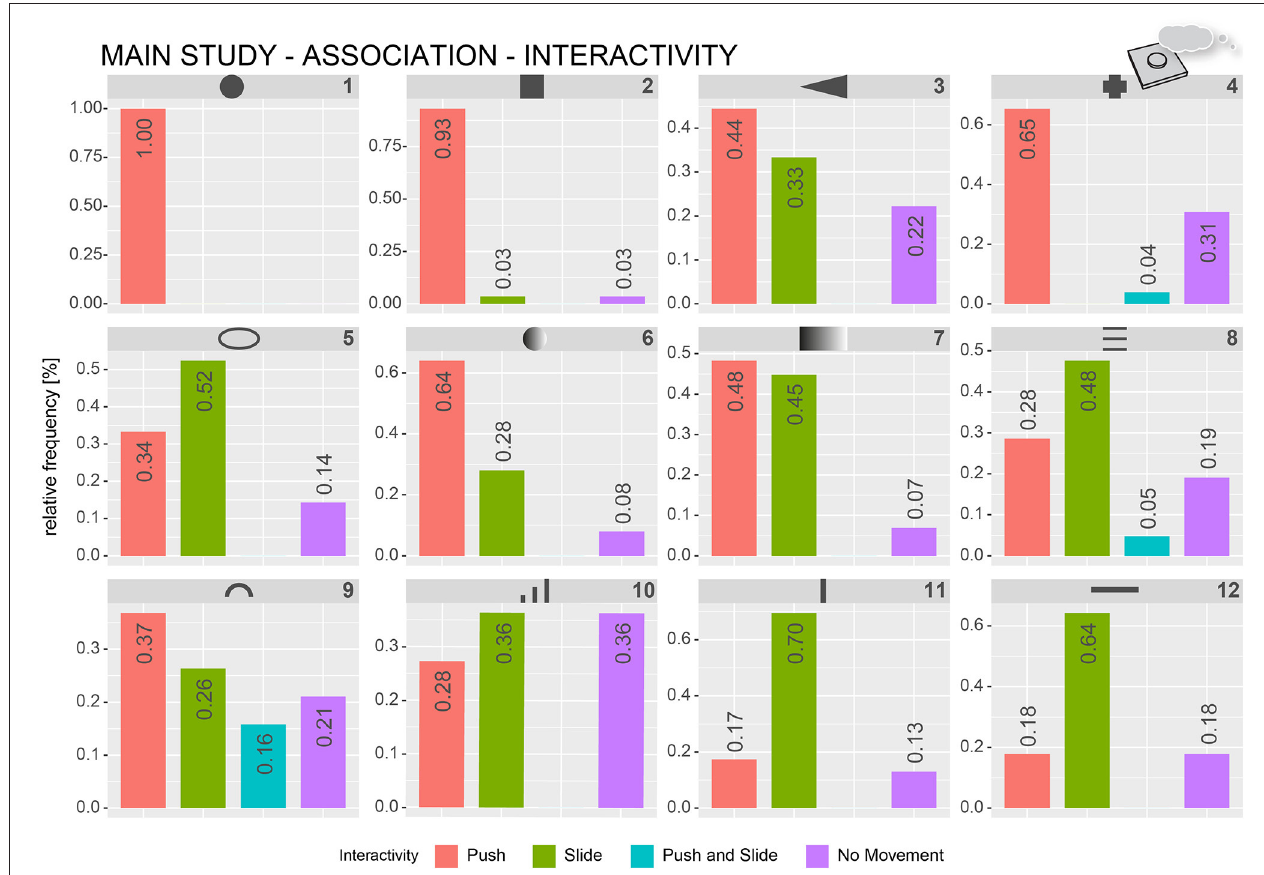
FIGURE 9 | Relative frequencies of how often specific exploration-based categories were assigned by the raters to describe verbal interactivity associations of the participants. The numbers represent the relative frequency per category.